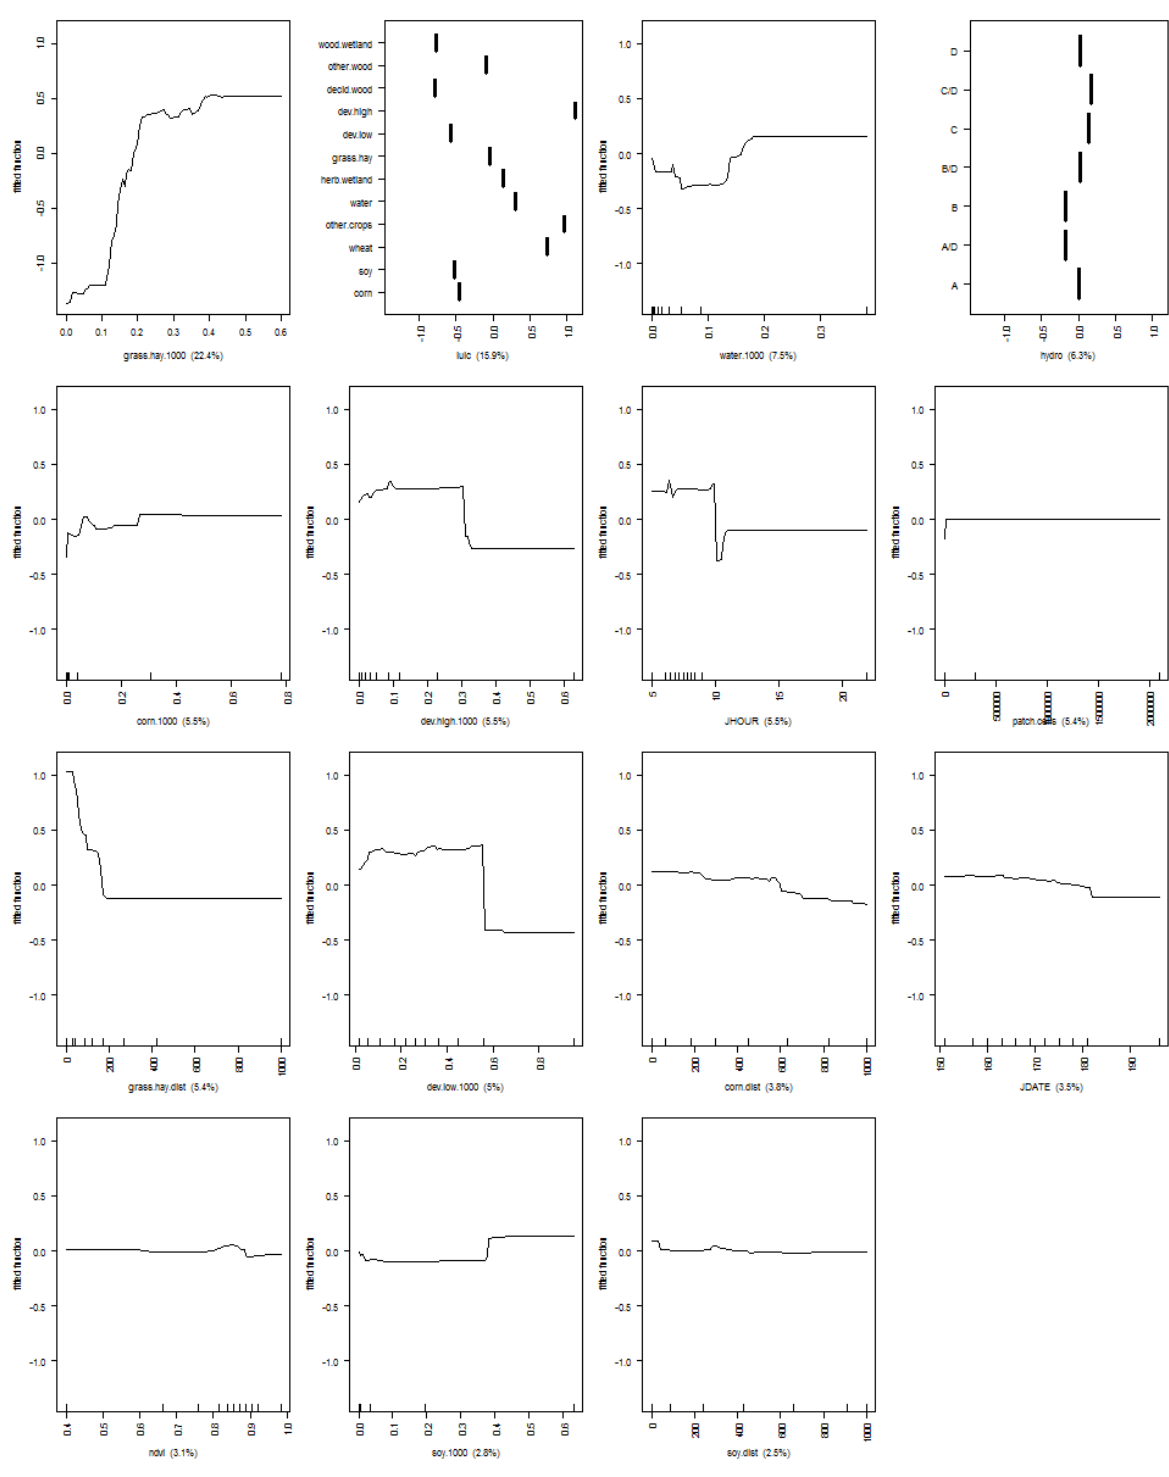
Figure A1.4b. Response curves for Eastern